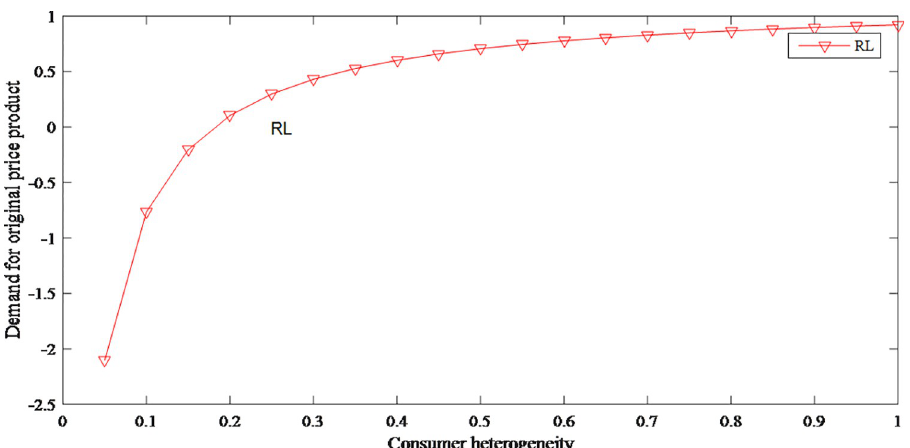
Fig 16. The impact of consumer heterogeneity on demand for original price product.